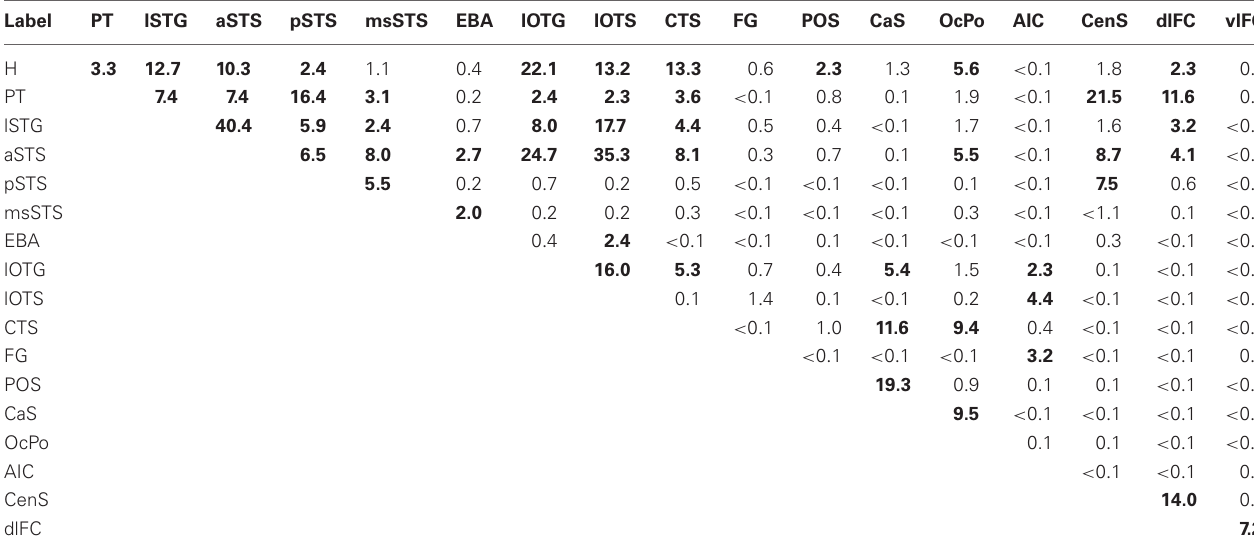
Note: The table lists group average ROI-to-ROI white-matter track connectivity indices (TCI) reflecting normalized track probabilities. The number of tracks connecting ROIs were divided by the product of voxels of each ROI. TCI-values are given in 10 − 8 . Large values reflect high probabilities of tracks between the voxels of each ROI. Values greater than 2 are highlighted in bold. See also Table 1 for